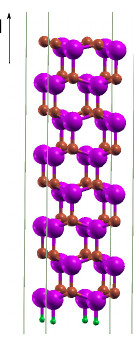
Figure 1. Exemplary slab model of the wz-GaN ( 000¯1 ) clean surface. Big violet and small brown balls represent Ga and N atoms, correspondingly. The smallest green balls denote saturating H pseudoatoms.